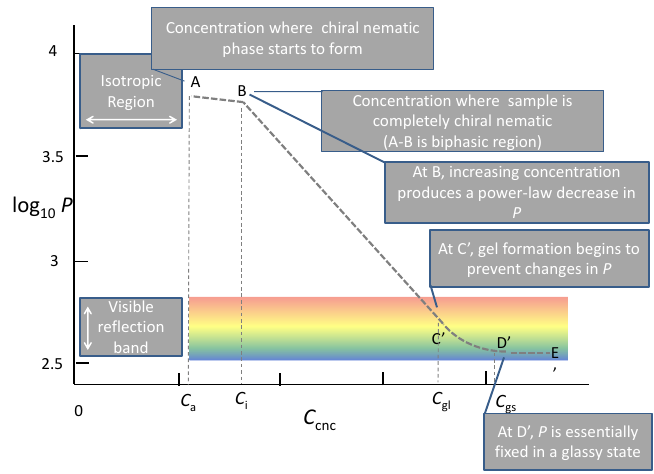
Figure 1. Schematic illustrating the observed dependence of the chiral nematic pitch, P , as a function of cellulose nanocrystals (CNC) concentration, C cnc , as water evaporates to form a solid film. The rainbow area represents the range of P values that reflect visible light. C a and C i represent critical concentrations for the onset and completion of the chiral nematic phase separation, respectively, and C gl and C gs represent concentrations for gel and solid glass formation, respectively (adapted from [10]).